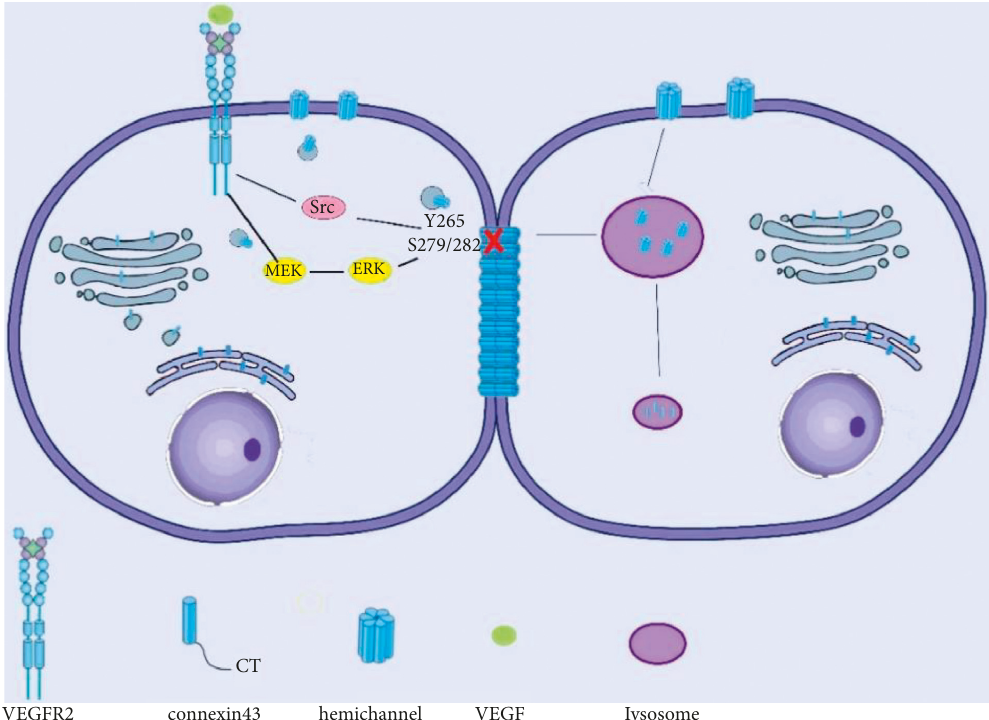
Figure 1: The connexin gene is transcribed and translated from the nucleus to the endoplasmic reticulum, where it undergoes simple modification. The connexin is then transfered to the Golgi apparatus, where it is assembled and finally transported to the cell membrane’s surface. Every six connexins gather on the surface of the cell membrane to form a hemichannel. Additionally, hemichannels aid in signal communication between the cell and its surroundings. On the other hand, the two hemichannels in each cell are combined to form a gap junction, which may facilitate cell-cell communication. The CT terminal of the connexin plays an important role in its function, since it promotes endocytosis and aids in their entry into the lysosome for degradation. VEGF can regulate connexin function in two ways: It can stimulate the MEK/ERK pathway, hence inhibiting the phosphorylation of Cx43 protein at S279/282. The other is Src-mediated phos- phorylation of Y265. Thus, by modifying the gap junction protein’s CT terminus, its function can be